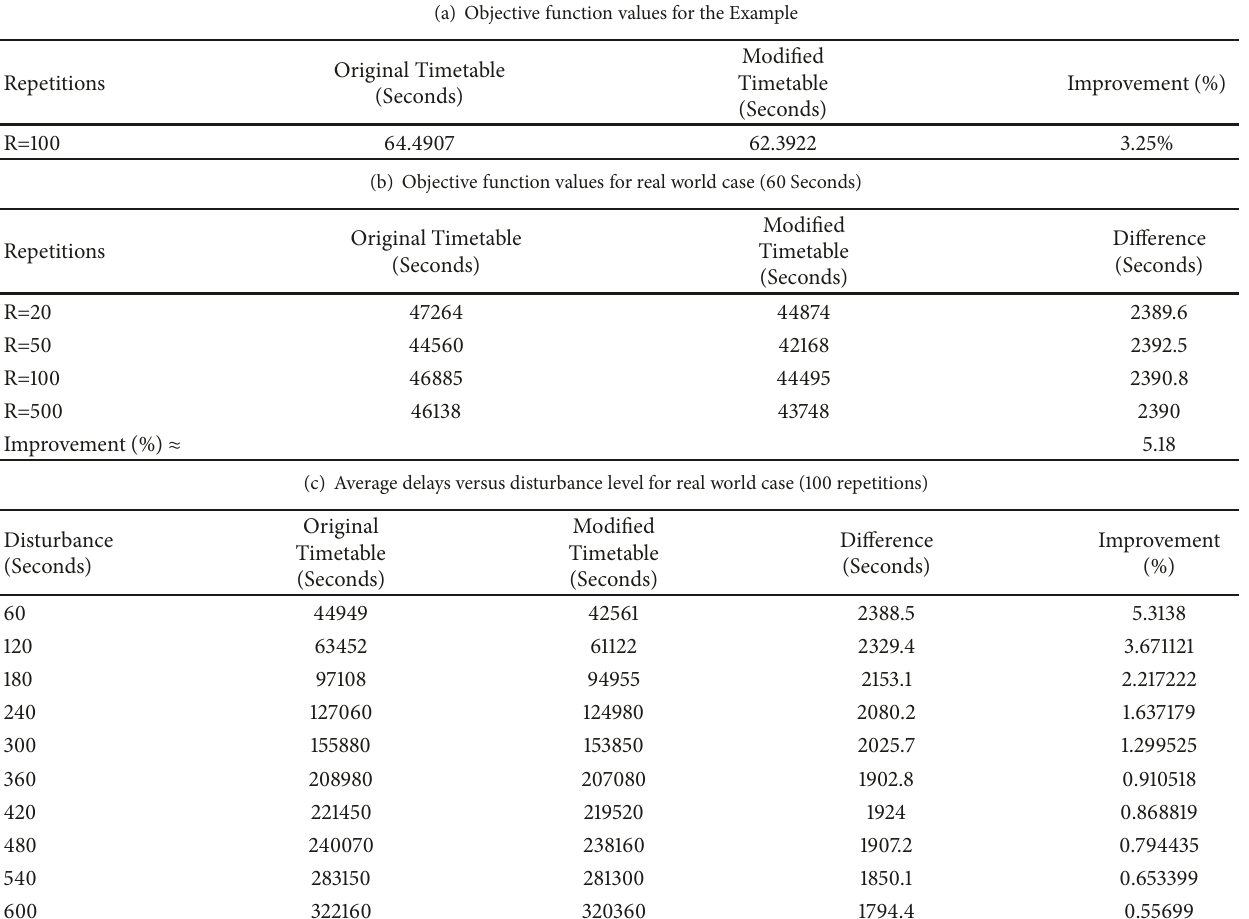
Table 3: Delay Evaluation